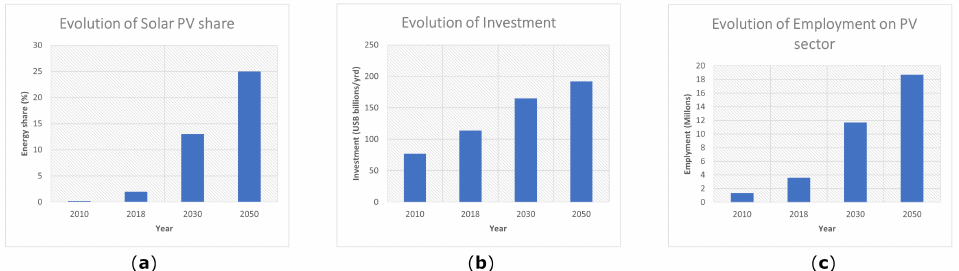
Figure 1. Evolution of the importance of PV sector (adapted from [7]). ( a ) Evolution of the energy share of PV systems; ( b ) evolution of the investment in PV energy; ( c ) evolution of employment in the PV